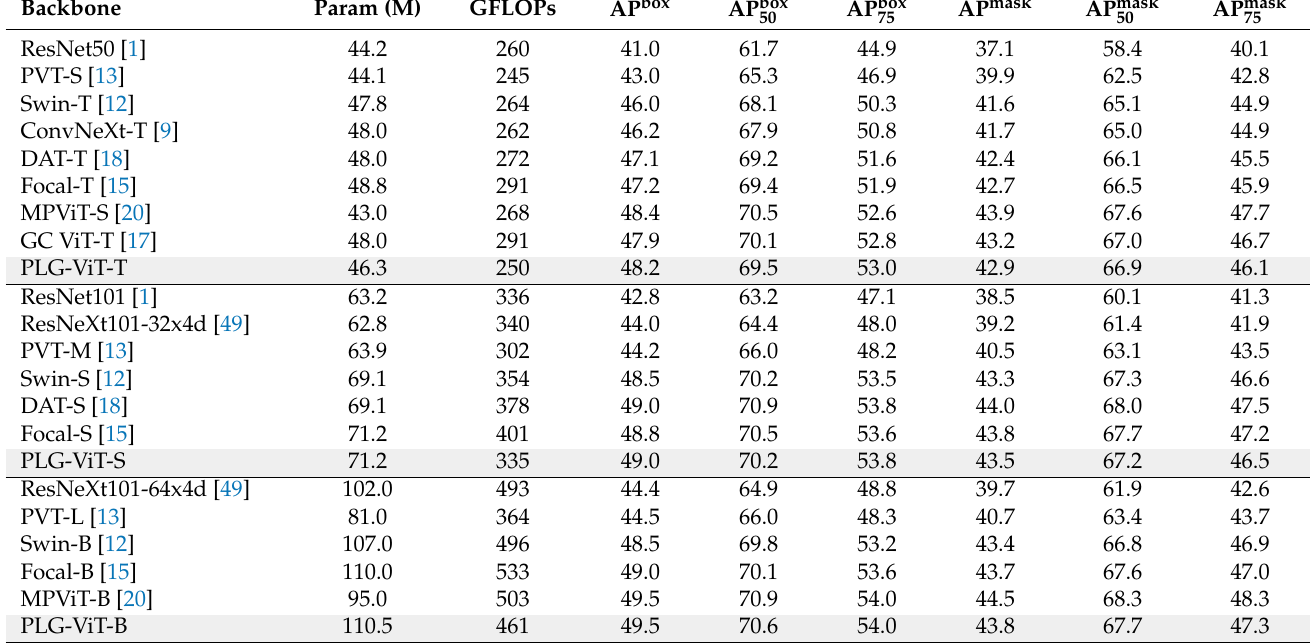
Table 2. COCO [22] instance segmentation results with Mask RCNN [56]. All models were trained with a 3 schedule and multi-scale inputs. GFLOPs were calculated with image size (1280, 800). Our × networks are highlighted in gray. All values are taken from the official